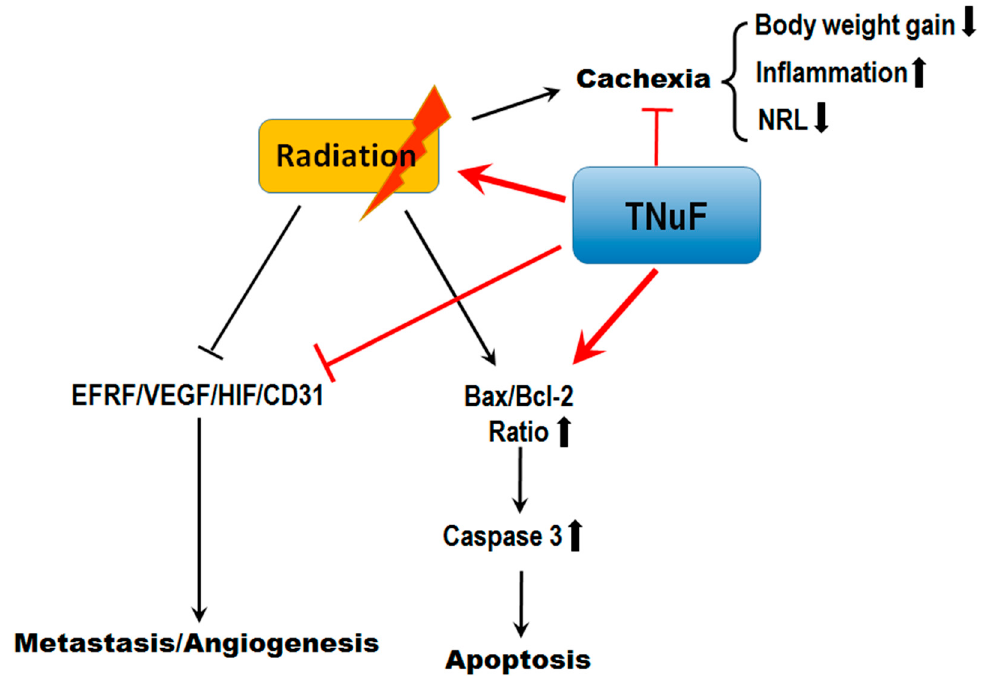
Figure 6. Proposed antitumor, metastasis inhibitory and cachexia improving model of TNuF in non-small-cell lung cancer (NSCLC)-bearing mice under radiation. In NSCLC-bearing mice, the TNuF administration significantly suppressed tumor growth and activated apoptotic cell death in NSCLC-bearing mice under radiation. The body-weight gain, inflammation and NRL were improved after TNuF administration, while the radiation-induced cachexia was mitigated. Mechanism analysis suggests that TNuF downregulates epidermal growth factor receptor (EGFR) and VEGF signaling pathways, inhibiting angiogenesis and metastasis. Accordingly, the present study may provide information regarding the TNuF administration with radiation therapy in lung cancer, and the regulation of EGFR/VEGF may be a promising strategy for treating lung cancer metastasis.